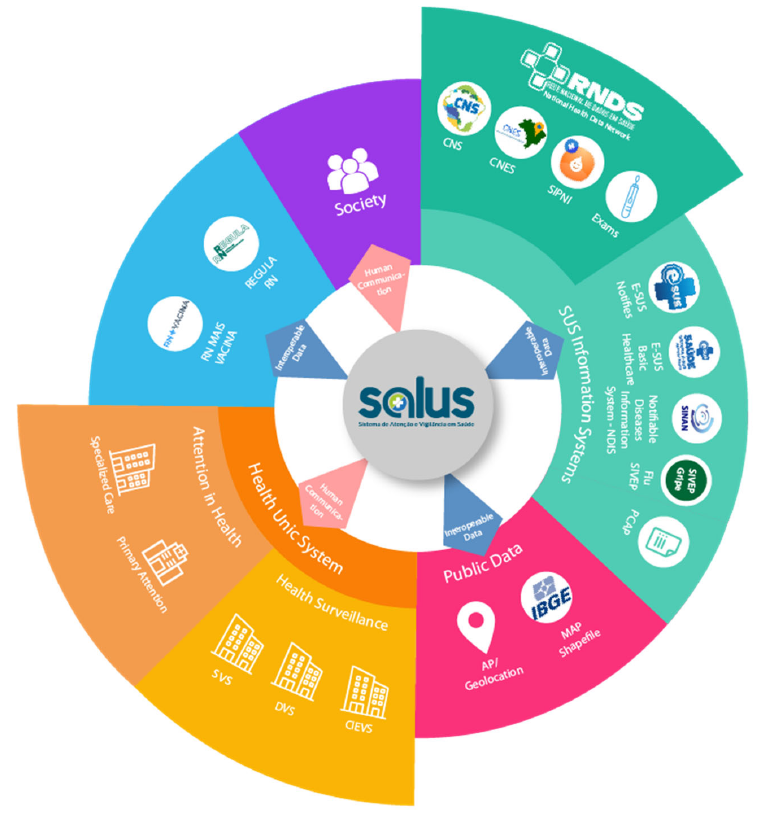
Figure 1. Overview of the architecture of the Salus Platform. Source: adapted from [35].